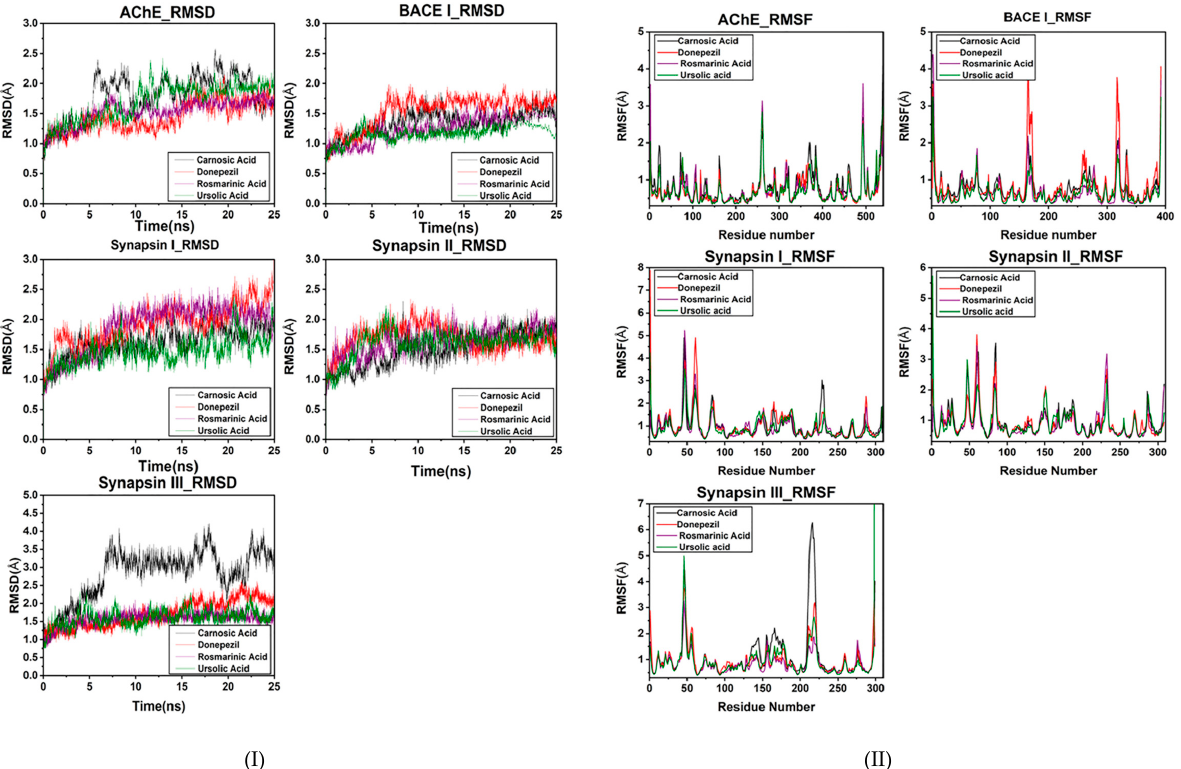
Figure 5. ( I ) RMSD plot of the bioactive compounds of R. officinalis with target proteins at 25 ns. ( II ) RMSF plot of AChE, BACE1, synapsin I, synapsin II and synapsin III with CA, RA, UA and donepezil respectively.